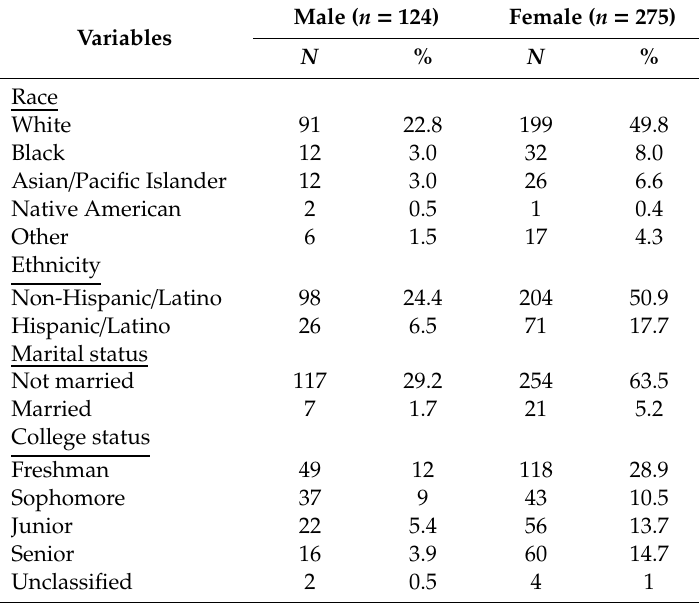
Table 1. Participants’ gender 1 , race, marital status, and college status.